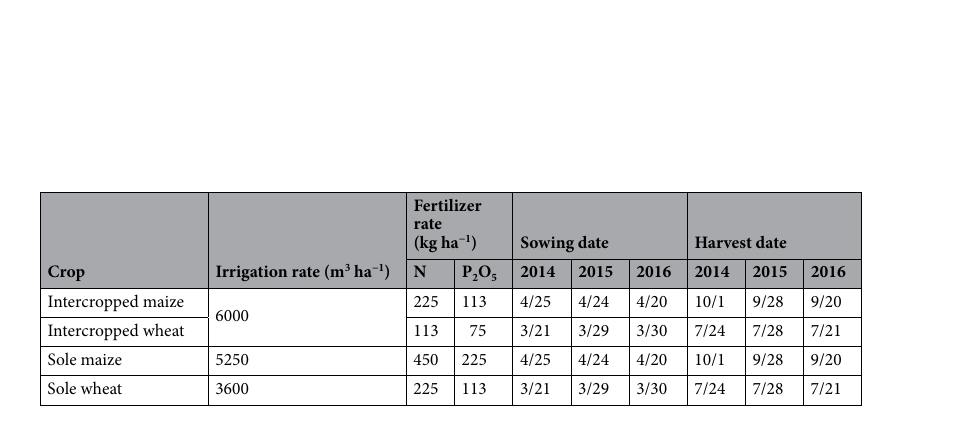
Table 5. Irrigation rate, fertilizer rate, sowing date, and harvest date of crops in sole and intercropping patterns, in 2014, 2015, and 2016.